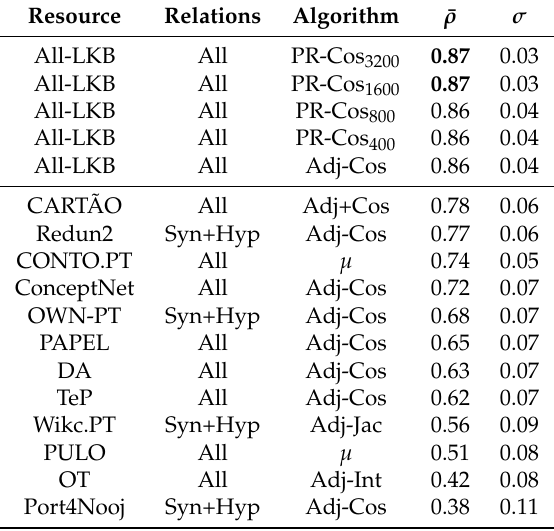
Table 7. Performance overview of LKBs in the PT-65 test.